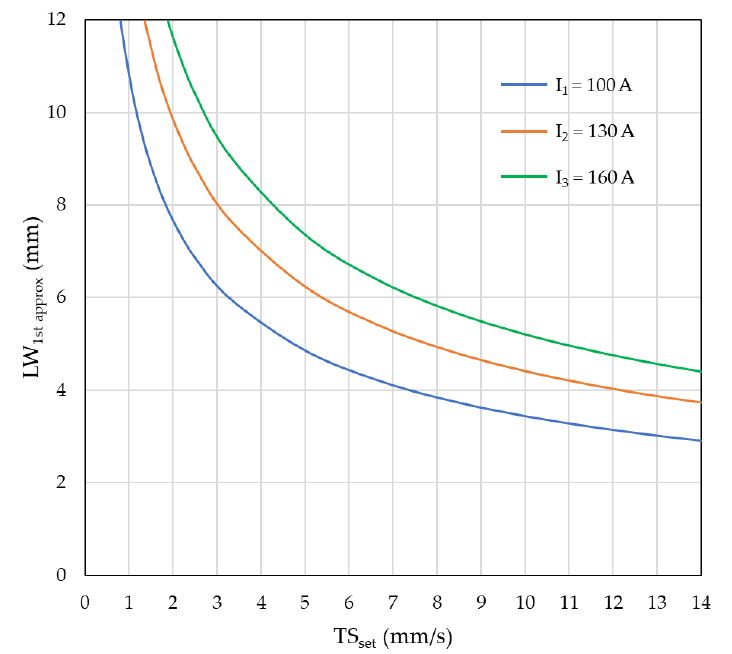
Figure 6. First approximation operational map obtained in the mock design, representing the boundaries for the actual workable currents (LW is still estimated by Equation (5)).